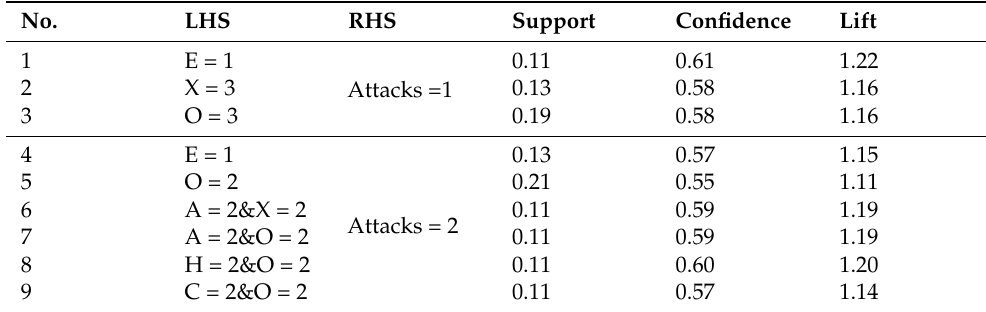
Table 3. Association rules between personality traits and in-game behaviors in Study 1.